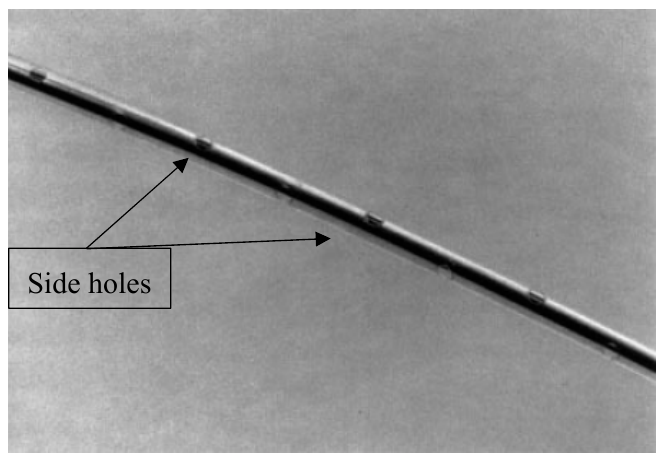
Figure 3. Catheter design similar to that used in 1961, with multiple side holes [24] .